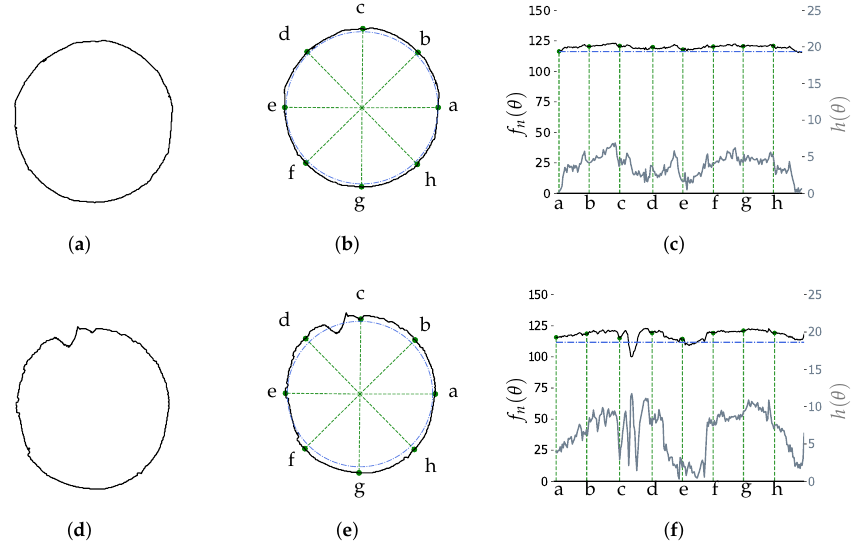
Figure 14. Examples of two circles of M2. ( a ) Shape of the first segmented circle. ( b ) Characteristic points to measure the distortion of the first circle, according to the standard. ( c ) Graphical representa- tion of the distribution (first circle). ( d ) Shape of the second segmented circle. ( e ) Characteristic points to measure the distortion of the second circle, according to the standard. ( f ) Graphical representation of the distribution of distances (second